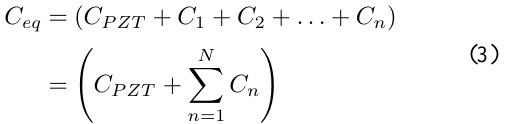
Fig. 2. Parallel connection of (a) n capacitors and (b) an equivalent